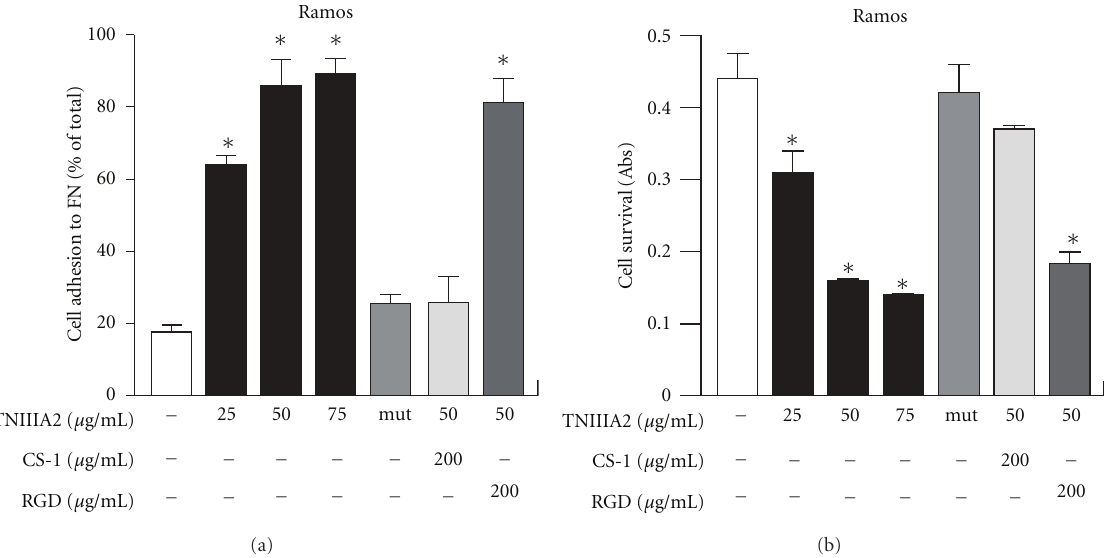
Figure 2: E ff ect on cell growth of forced adhesion of Ramos cells to FN. (a) shows the results of cell adhesion assay. The percentage of adhere cells are shown relative to the total number of cells seeded into the well. In (b), the e ff ect of induced adhesion to FN on Ramos cell survival was shown. CS-1: connecting segment 1 peptide. (figures were modified from Figure 1 of [19]). ∗ P < 0 . 05 versus untreated